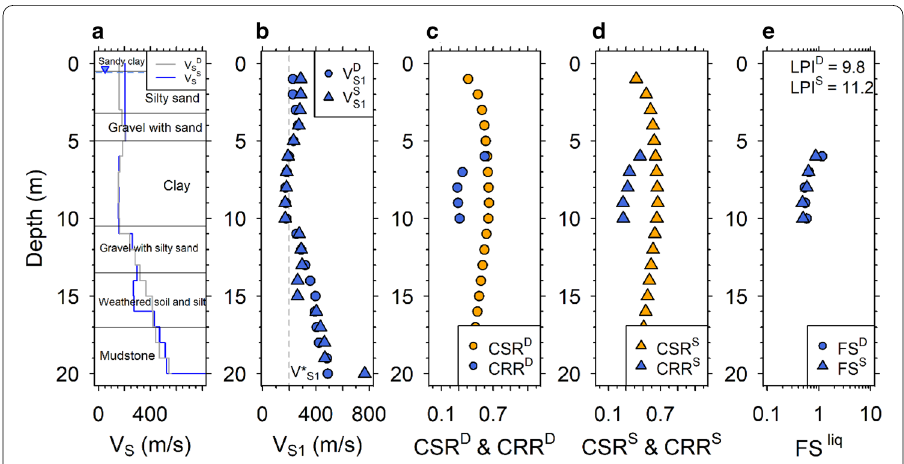
Fig. 5 Profiles of a V S S and V S D ; b V S 1 ; c CSR D and CRR D ; d CSR S and CRR S ; and e FS D and FS S at Site 3, where sand boils were observed (liquefied site). The LPI is shown at the top right of ( e ). The silty sand at a depth of 3 m has a fines content of 12.8%